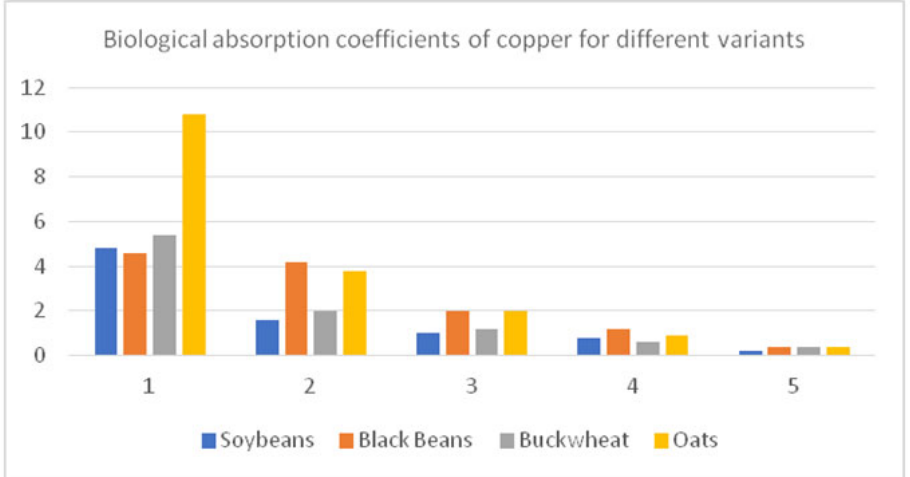
Figure 10. Values of coefficients of biological absorption Ax (2) of copper at the different variants of the experiments (different total pollution index Zc).